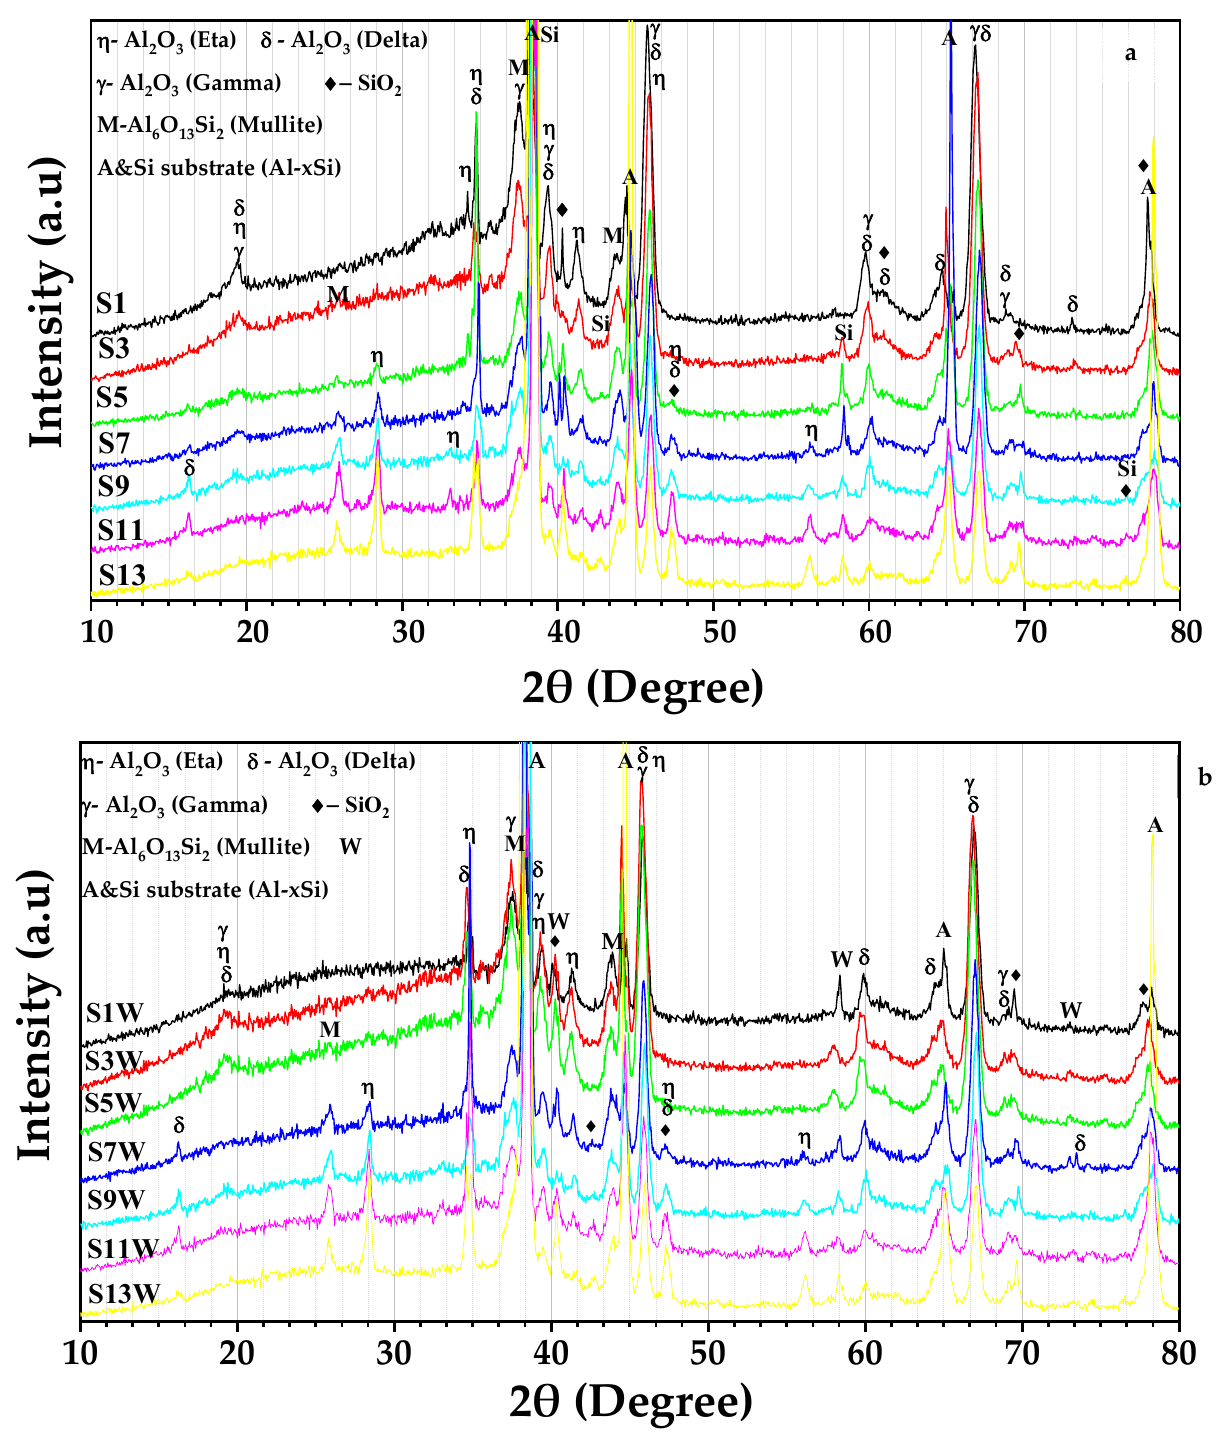
Figure 13. XRD patterns of the PEO-coated specimens on substrates with various Si content in ( a ) without and ( b ) with Na 2 WO 4 .